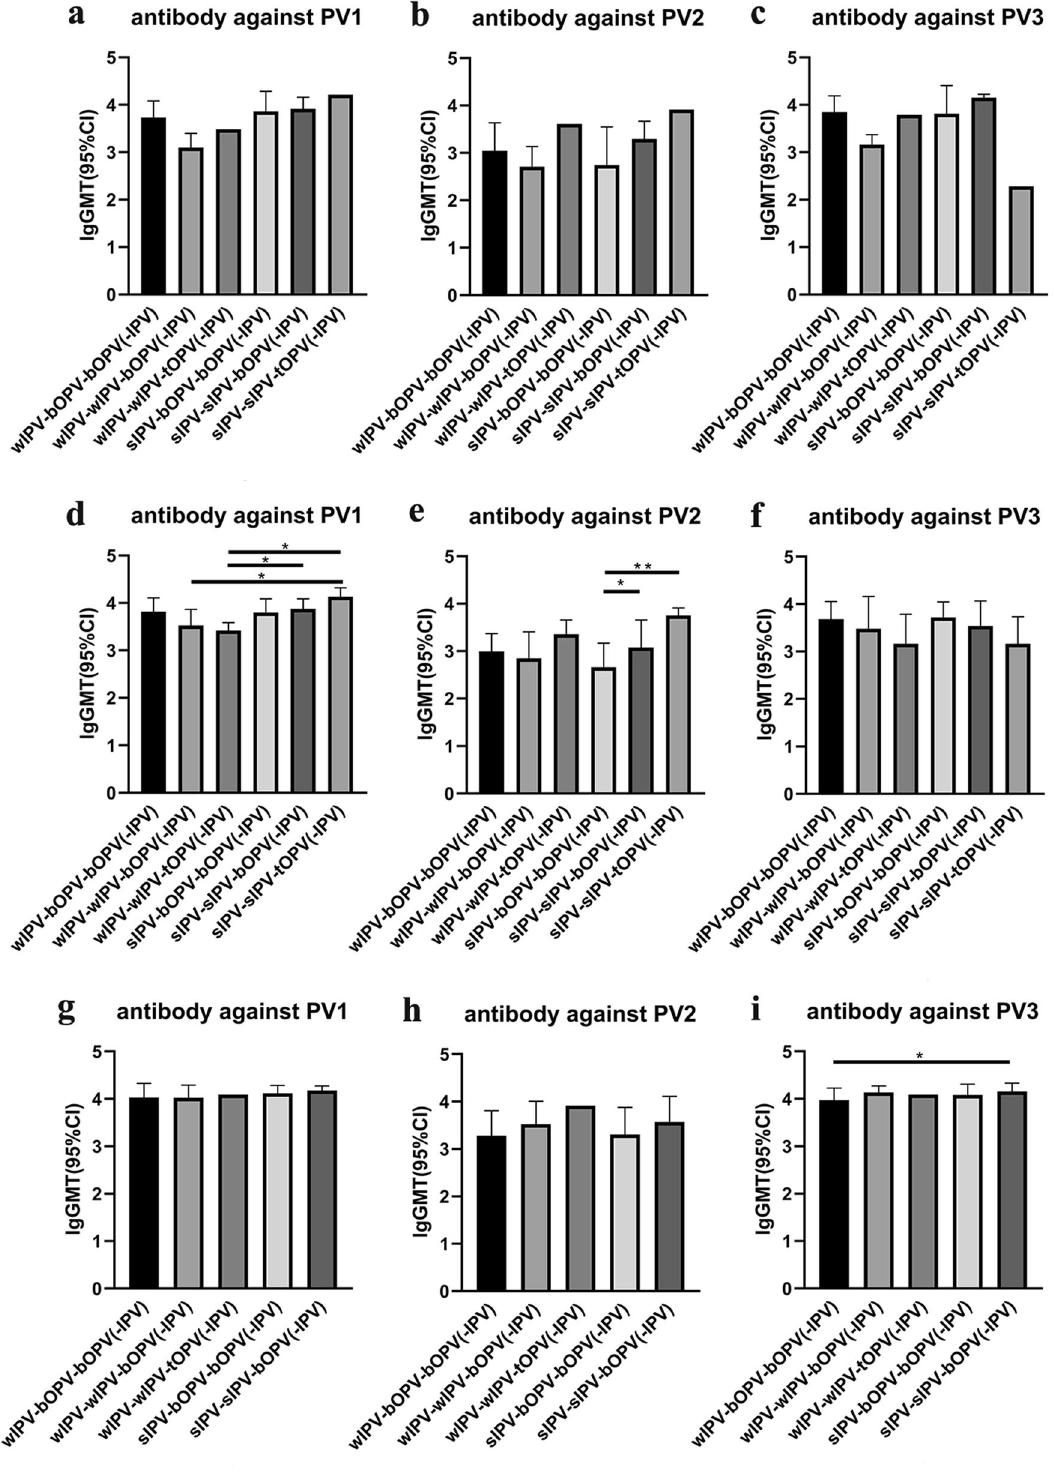
Fig. 2 GMT for neutralizing antibody against PV1, PV2, and PV3 at 28 days after revaccination with IPV. Differences in antibody levels between groups were compared after log-transformation of the GMT (95%CI). The sample size is 1 ( n = 1), so GMT and 95%CI cannot be calculated. Statistical test: Kruskal – Wallis test; * p < 0.05; ** p < 0.001. error bars: Standard Deviation (s.d.). a – c Re-vaccined with IPV at 24 months of age. wIPV-bOPV-bOPV(-IPV): n = 28; wIPV-wIPV-bOPV(-IPV): n = 2; wIPV-wIPV-tOPV(-IPV): n = 1; sIPV-bOPV-bOPV(-IPV): n = 49; sIPV-sIPV- bOPV(-IPV): n = 4; sIPV-sIPV-tOPV(-IPV): n = 1. d – f Re-vaccined with IPV at 36 months of age. wIPV-bOPV-bOPV(-IPV): n = 24; wIPV-wIPV-bOPV (-IPV): n = 12; wIPV-wIPV-tOPV(-IPV): n = 5; sIPV-bOPV-bOPV(-IPV): n = 53; sIPV-sIPV-bOPV(-IPV): n = 23; sIPV-sIPV-tOPV(-IPV): n = 5. g – i Re- vaccined with IPV at 48 months of age. wIPV-bOPV-bOPV(-IPV): n = 18; wIPV-wIPV-bOPV(-IPV): n = 23; wIPV-wIPV-tOPV(-IPV): n = 1; sIPV-bOPV- bOPV(-IPV): n = 27; sIPV-sIPV-bOPV(-IPV): n = 20; sIPV-sIPV-tOPV(-IPV): n = 0.